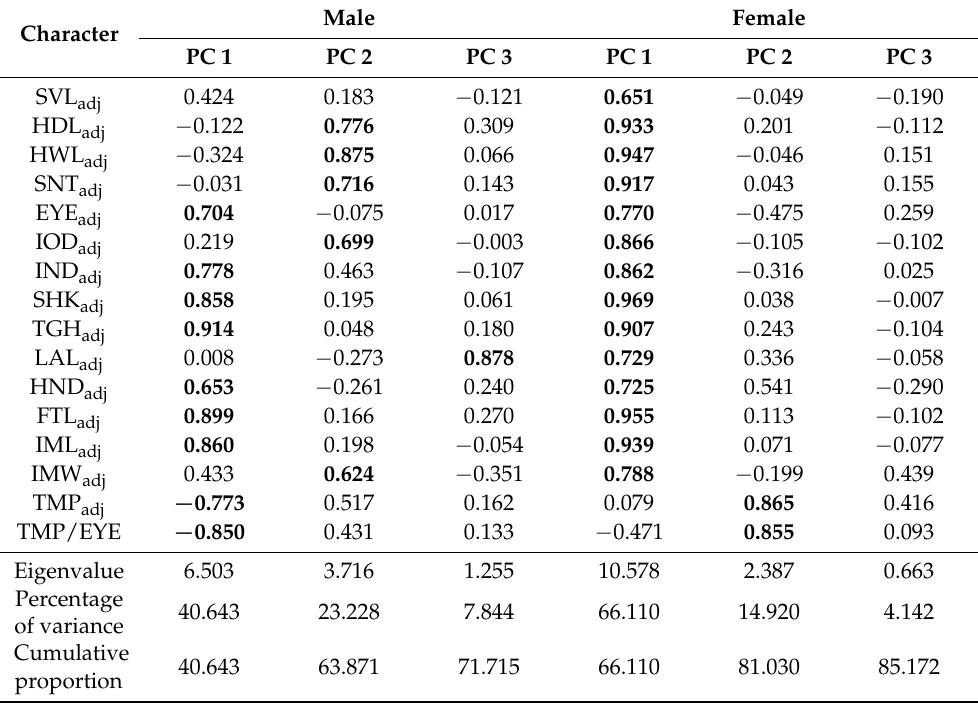
Table 3. Factor loadings on the first three principal components (PC) of 16 morphological characters of males and females of Limnonectes pseudodoriae sp. nov . and L. doriae . Bold figures indicate high